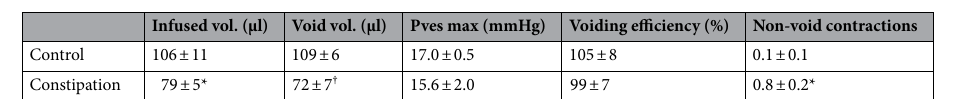
Table 3. Comparison of urodynamic parameters between the groups. The constipation group showed a significant decrease in bladder capacity, voided volume, and a significant increase in the number of non-void contractions compared to the control group (N = 4 per each group). Mean ± SE, *p < 0.05 and † p < 0.005 vs. the control group, Pves max, maximum intravesical pressure at